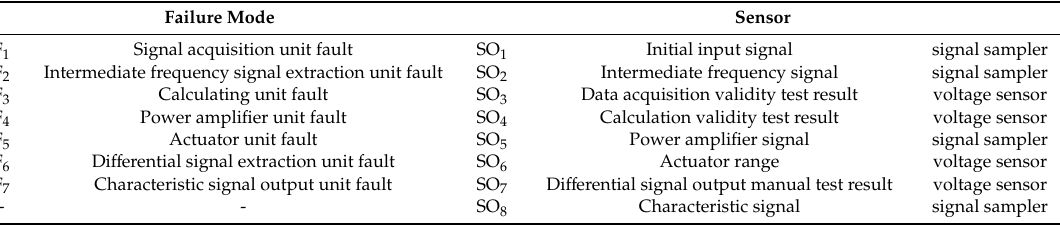
Table 3. The information about the failure modes and sensors.